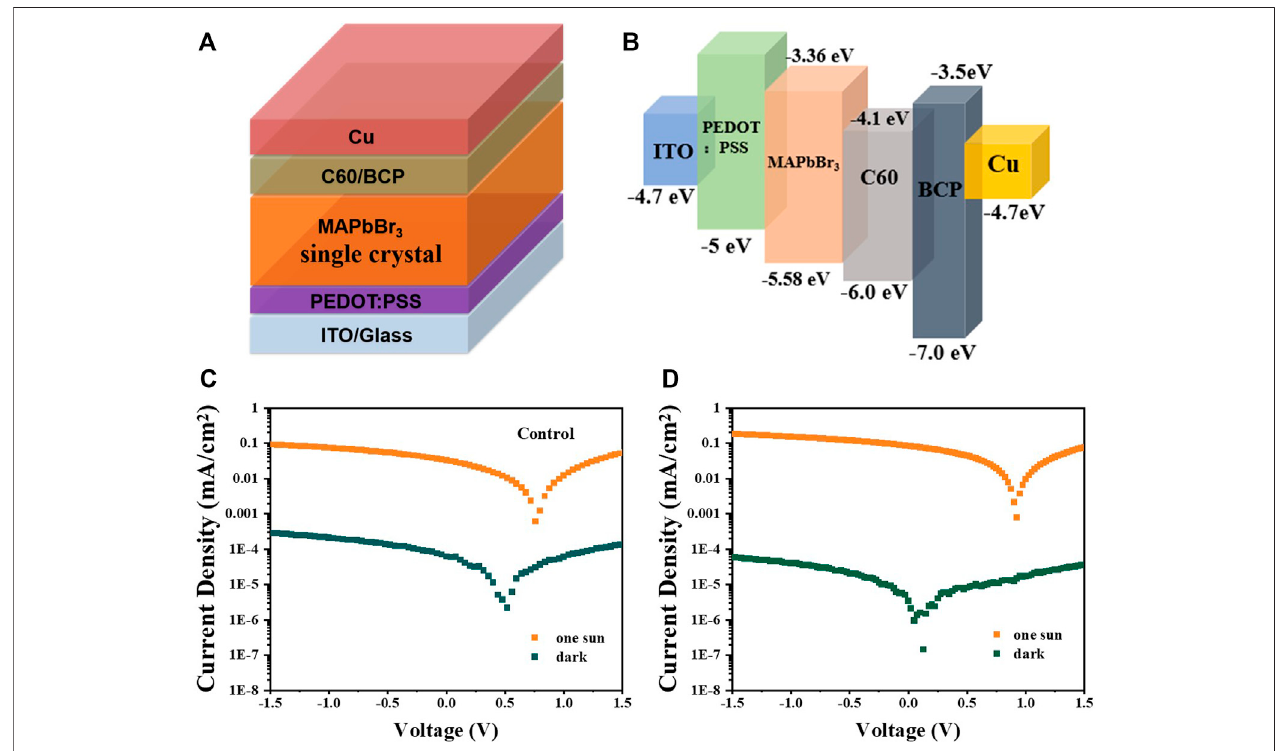
Frontiers in Chemistry |